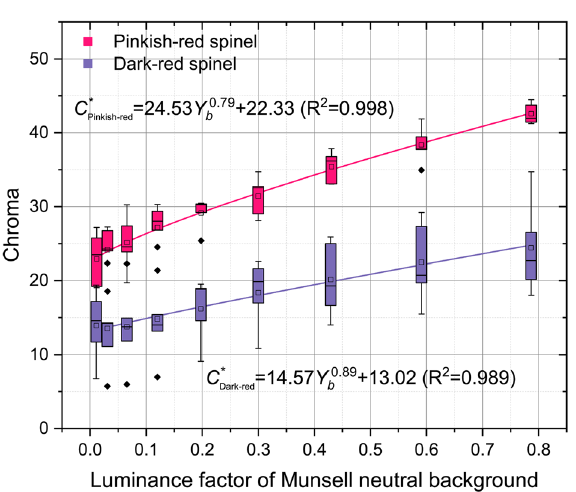
Figure 8. The Chroma of spinel increases with the luminance factor ( Y b ) of the Munsell neutral background in power